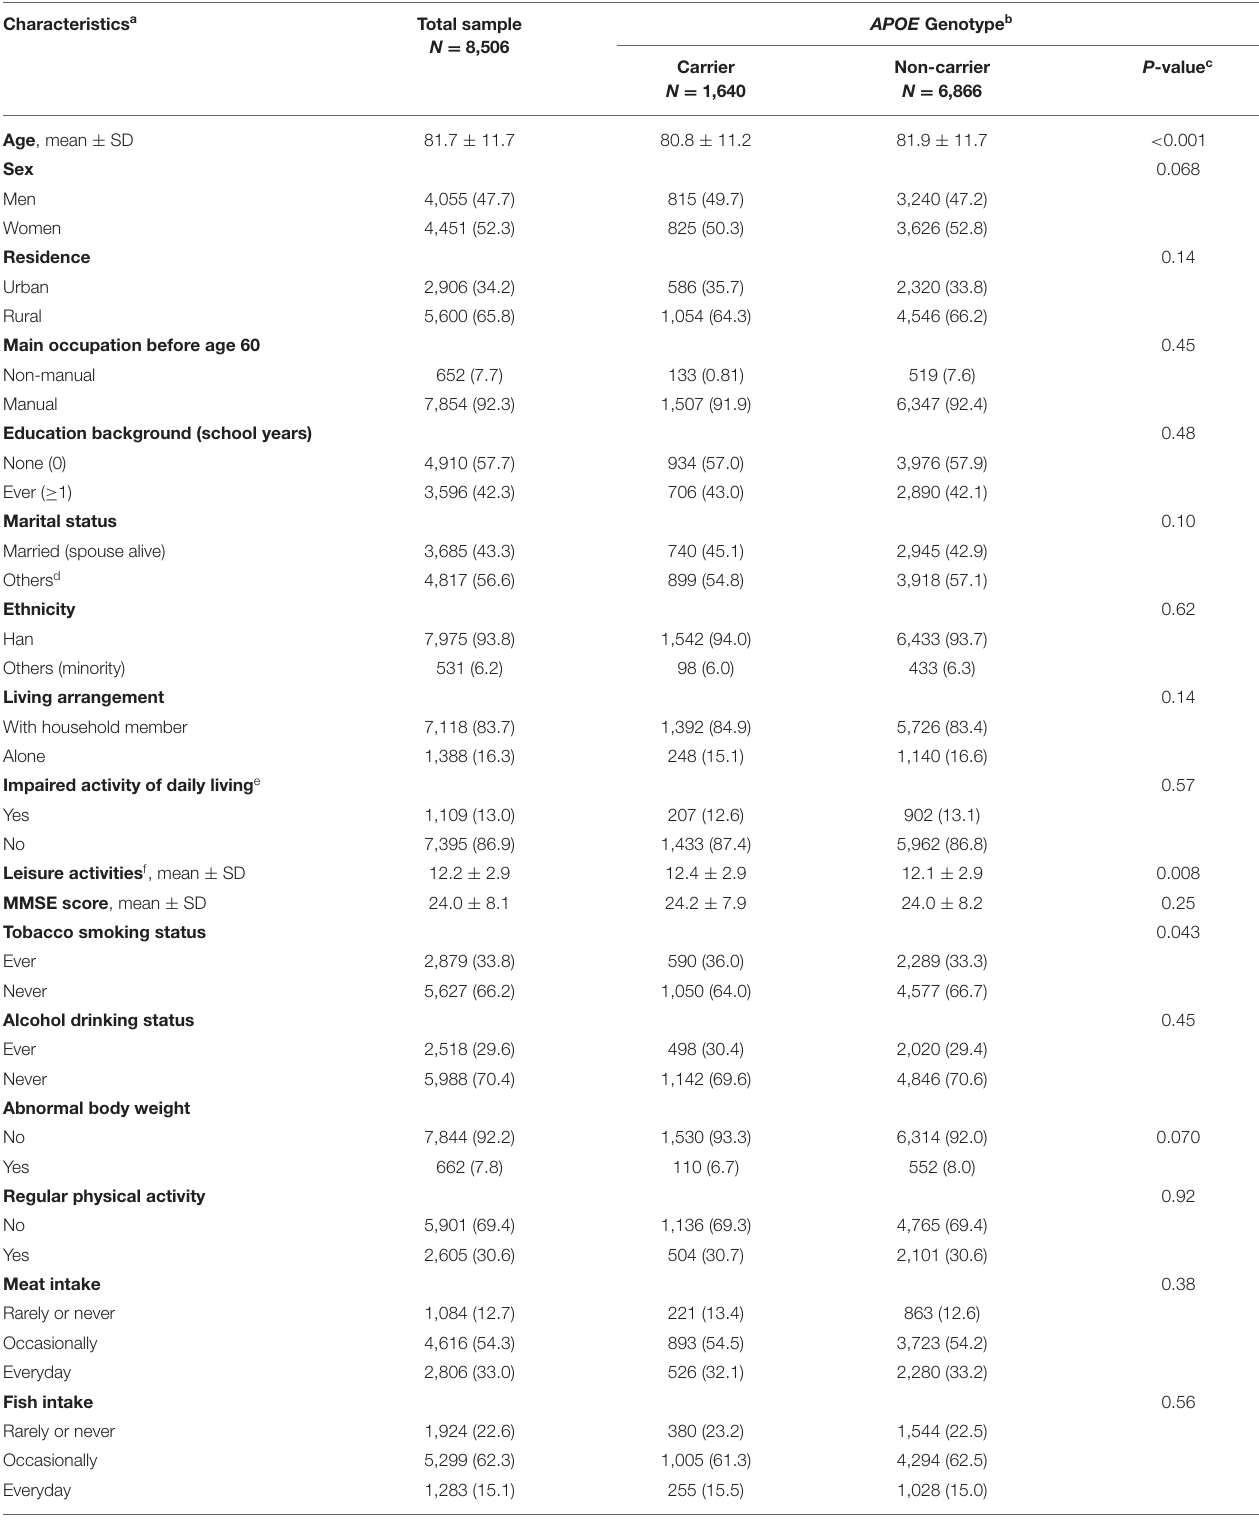
TABLE 1 | Characteristics of the 8,506 participants by APOE